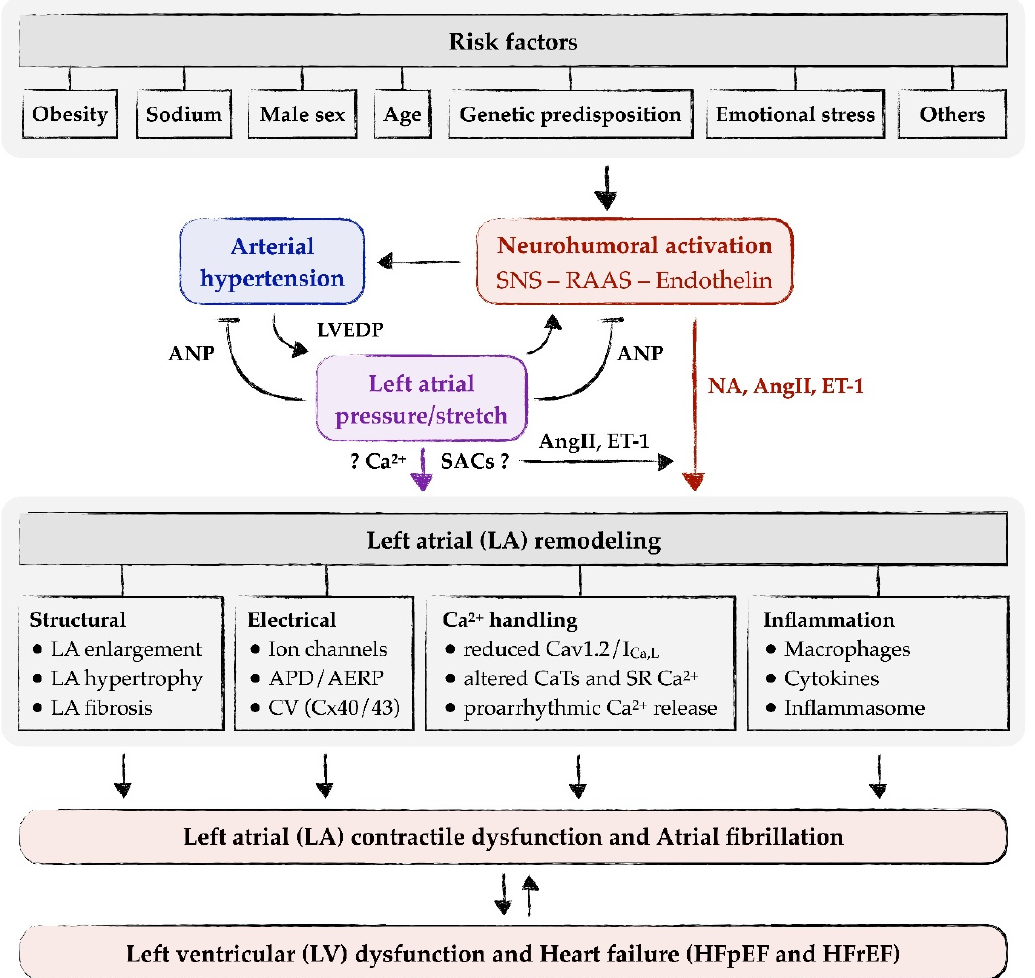
Figure 1. Risk factors for, initiating mechanisms of, LA remodeling in, and consequences of essential hypertension.